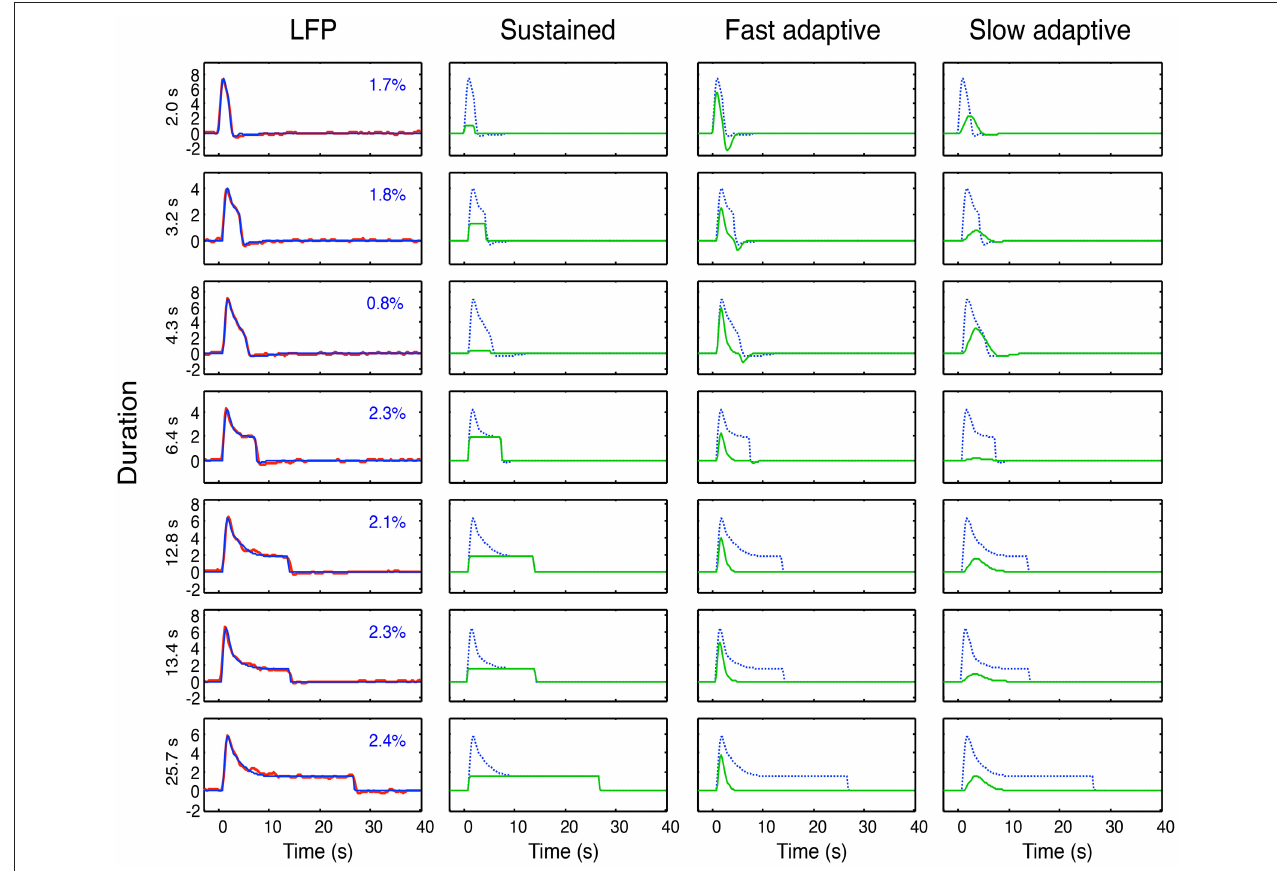
FIGURE 6 | Left column: Overall neural model fits (blue curves) to the average LFP responses (red curves) at each of 7 durations. Proportion of variance unaccounted for (R 2 ) shown as insets. Three right columns: Optimized sustained, fast and slow adaptive components (green curves for each duration) required to provide the overall neural model fits (blue curves). Note that residual variance (1– R 2 ) is less than 3% in all cases, and must be considered to have fully characterized the LFP dynamics of V1.